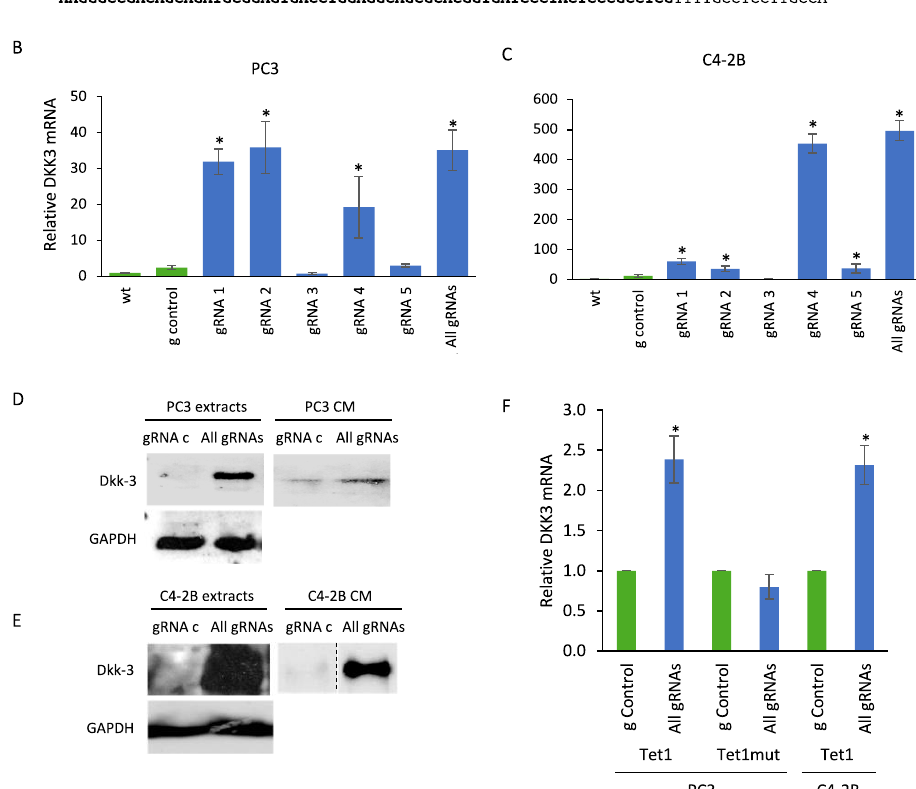
Figure 2 . CRISPR-mediated induction of DKK3. ( A ) DKK3 gene promoter with the positions of gRNAs, PAM sequences (underlined) and translation start (blue). ( B , C ) Q-RT-PCR analysis of DKK3 mRNA expression in PC3 ( B ) and C4-2B ( C ) cells 48 h after transfection with dCas9-VPR and the indicated gRNAs; graphs show mean ± SD of triplicate wells, n = 5. * p < 0.05 versus control gRNA, one-way ANOVA and two-tailed Student’s t -test. ( D , E ) Western blots of cell lysates (extracts) and conditioned media (CM) from PC3 ( D ) and C4-2B ( E ) cells 5 d after transfection with dCas9-VPR and control gRNA (gRNA-C) or DKK3 gRNAs 1, 2, 3, 4 and 5 together (All-gRNAs) and treated for the first two days with 1 μg/mL puromycin, were probed for Dkk-3 and GAPDH. ( F ) DKK3 mRNA expression in PC3 and C4-2B cells after transfection with dCas9-Tet1CD (Tet1) or the inactive mutant (Tet1mut); graphs show mean ± SD of triplicate wells, n = 4; * p < 0.05 versus control gRNA , two-tailed Student’s t -test.